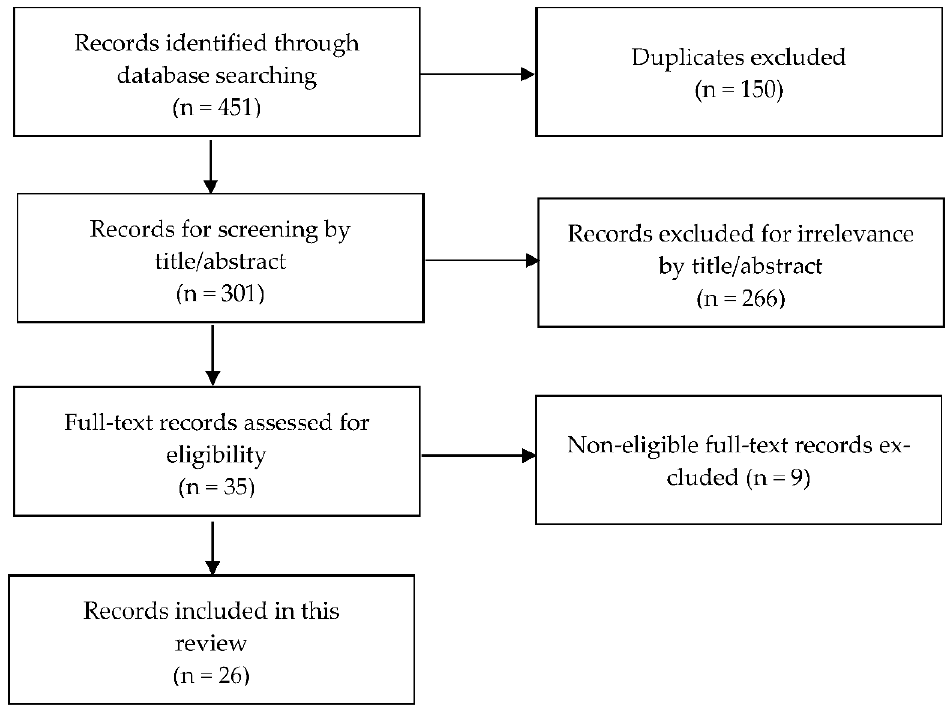
Figure 1. Selection process of records reporting on population pharmacokinetic models for infliximab in ulcerative colitis patients. The flowchart was based on the Preferred Reporting Items for Systematic Reviews and Meta-Analyses (PRISMA) guidelines [35].